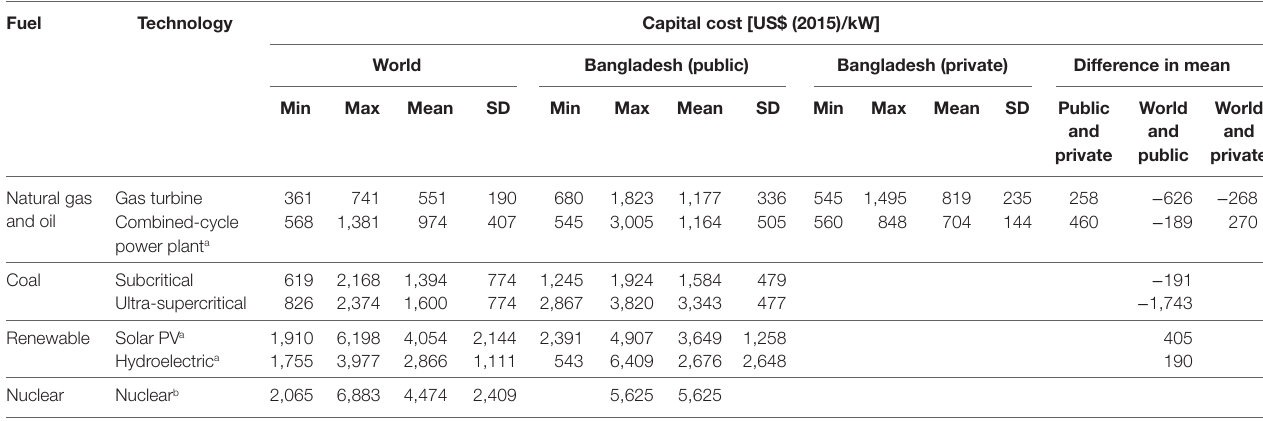
taBLe 3 | The capital cost of power generation plants in the World and Bangladesh. Power plants in Bangladesh are further disaggregated into public and private. Historical and projected costs are rounded to the nearest US$